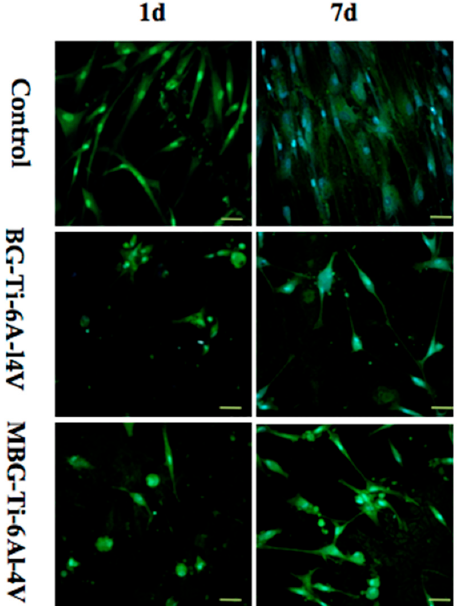
Figure 7. Confocal images showing the morphology and cytoskeleton of hBMSCs attached to the strut surfaces of the bare-metal Ti-6Al-4V, BG-coated Ti-6Al-4V and MBG-coated Ti-6Al-4V scaffolds at day 1 and day 7 (scale bar: 50 μ m).